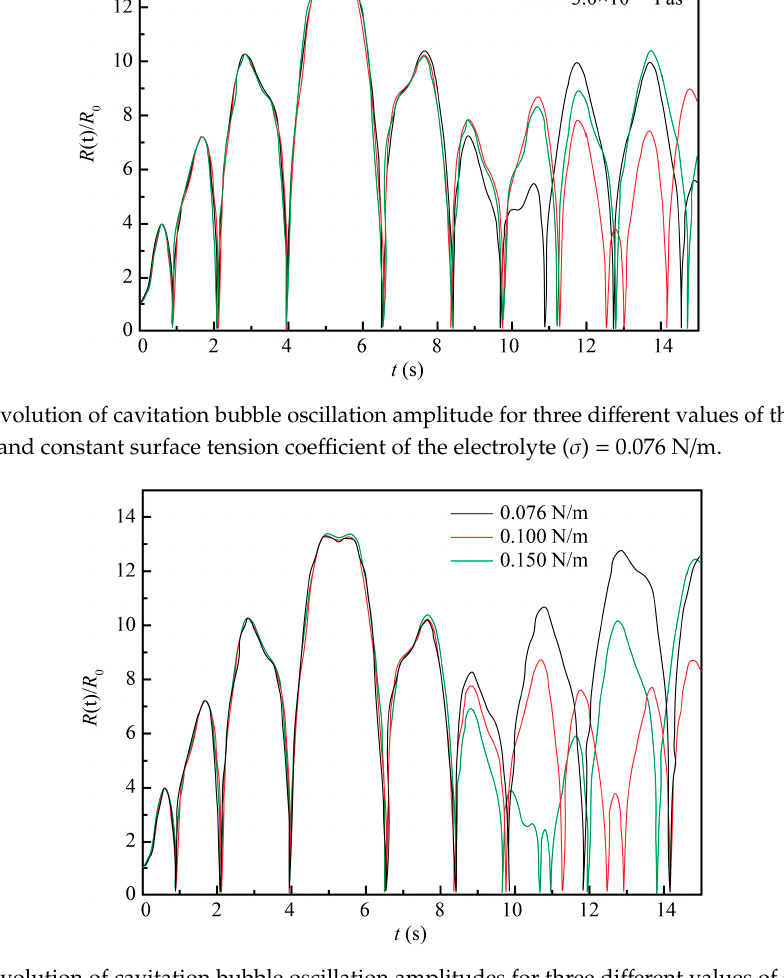
Figure 7. Evolution of cavitation bubble oscillation amplitudes for three different values of the surface tension coefficients and constant the liquid viscosity coefficient ( μ ) = 1.153 × 10 − 3 Pa ∙ s.